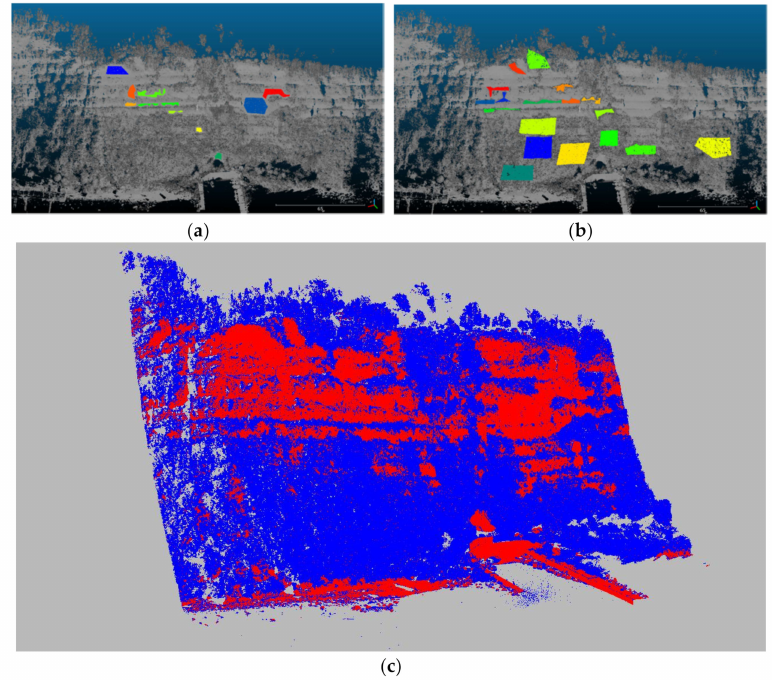
Figure 5. Vegetation filtering operation through supervised classification with CANUPO plug-in: ( a ) rock data set; ( b ) vegetation data set; ( c ) classified point cloud, in red the rock surface, in blue the vegetation coverage.